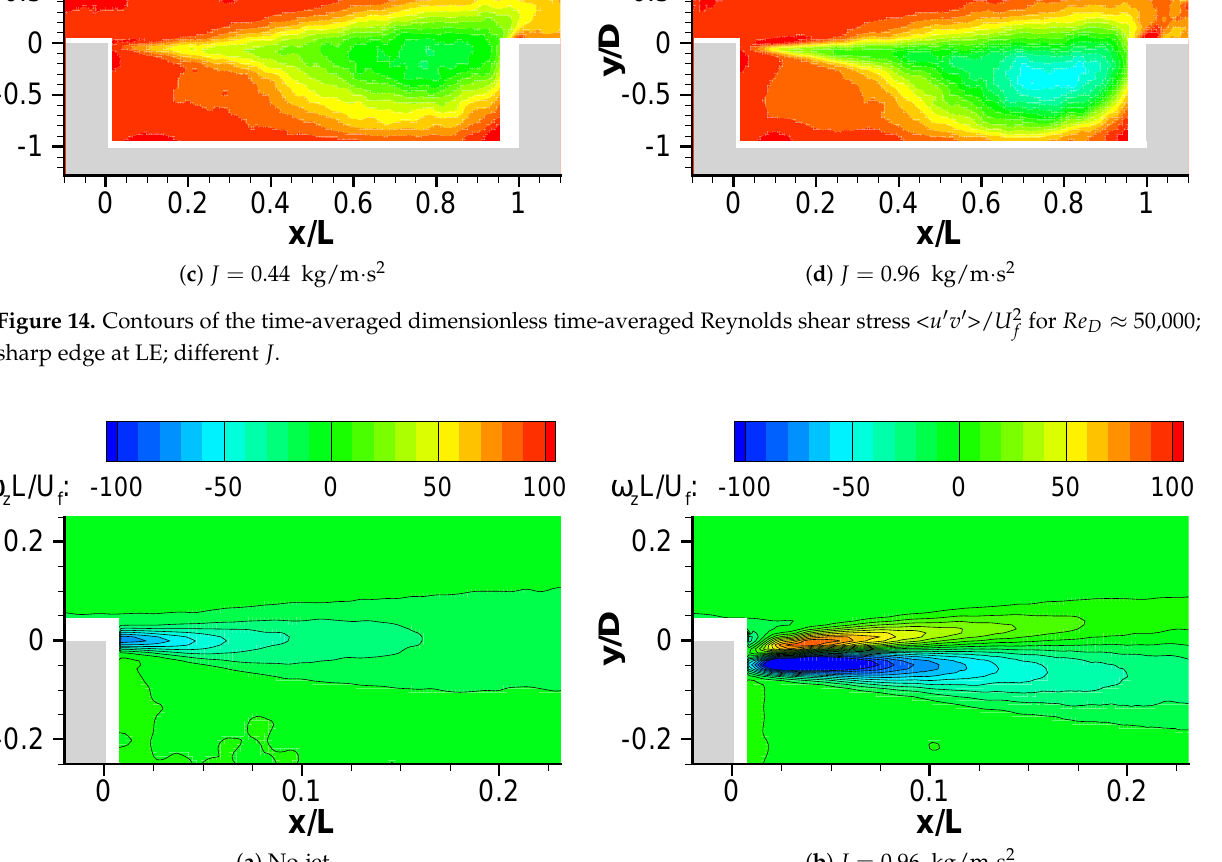
Figure 15. Contours of the time-averaged ω z L / U f at the cavity leading edge region for Re D ≈ 50,000; sharp edge at LE; different J